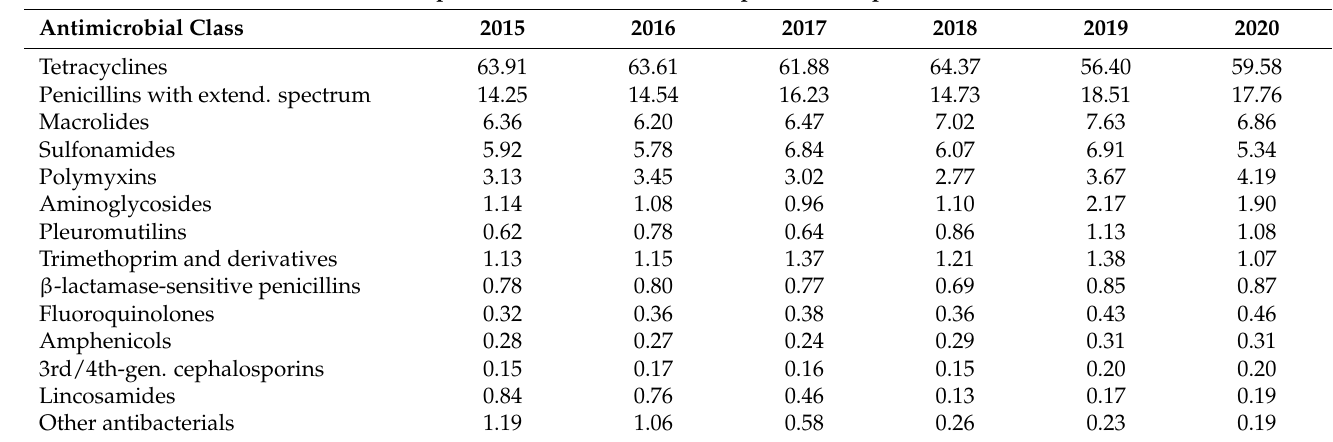
Table 3. Proportion in percent per year of antimicrobial classes dispensed for use in Austrian pigs, based on